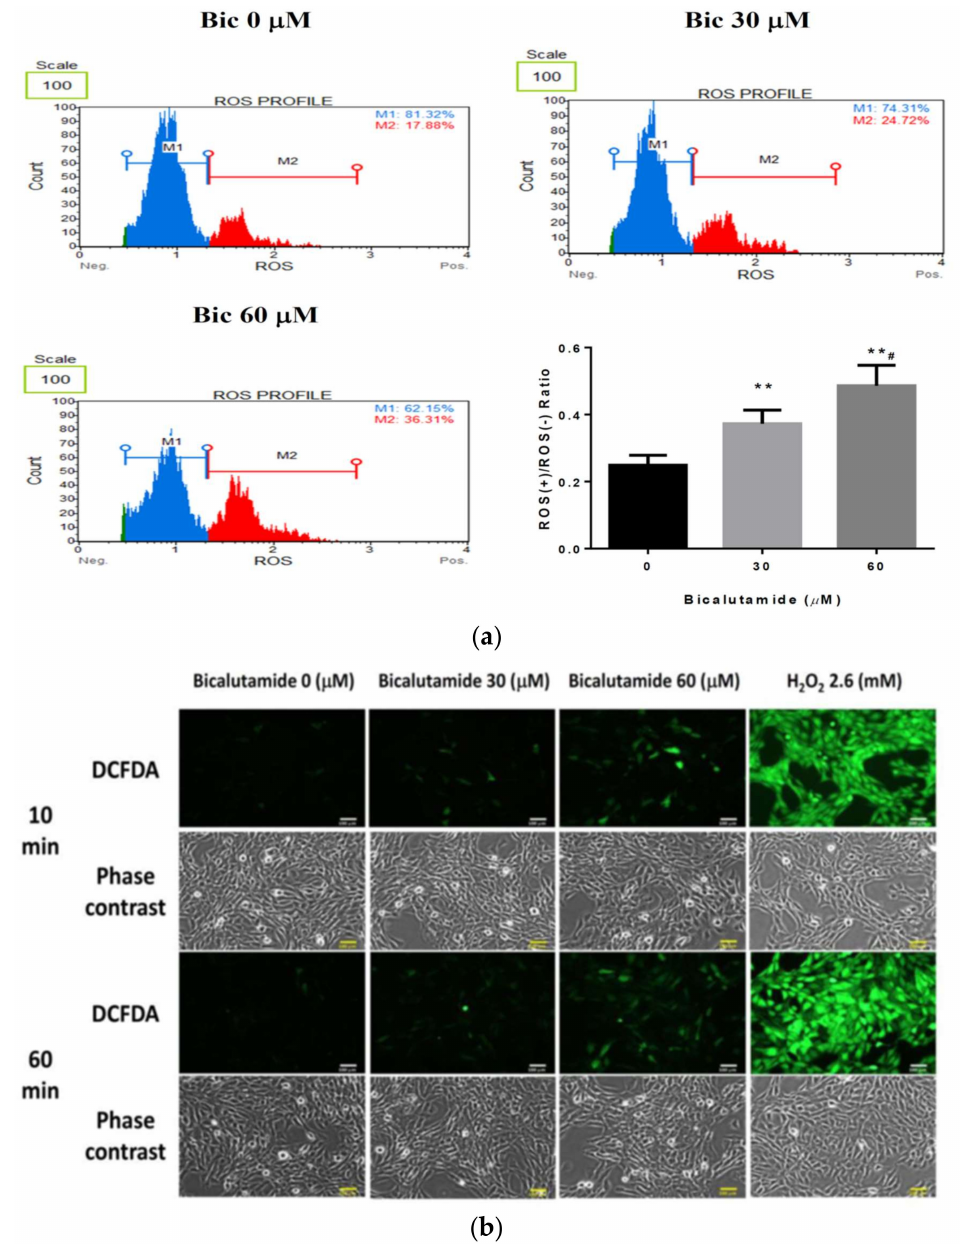
Figure 2. Measurement of oxidative stress. Reactive oxygen species (ROS) production induced by bicalutamide (Bic) was measured by ( a ) dihydroethidium (DHE) flow cytometry at 60 min and ( b ) dichlorodihydrofluorescein diacetate (DCFDA) staining at 10 and 60 min ( # p < 0.05; ** p < 0.01; Scale bar = 100 µ M). Bic dose-dependently induced ROS production, as shown by DHE flow cytometry and DCFDA fluorescence staining. Data are expressed as the mean ± standard deviation ( n =